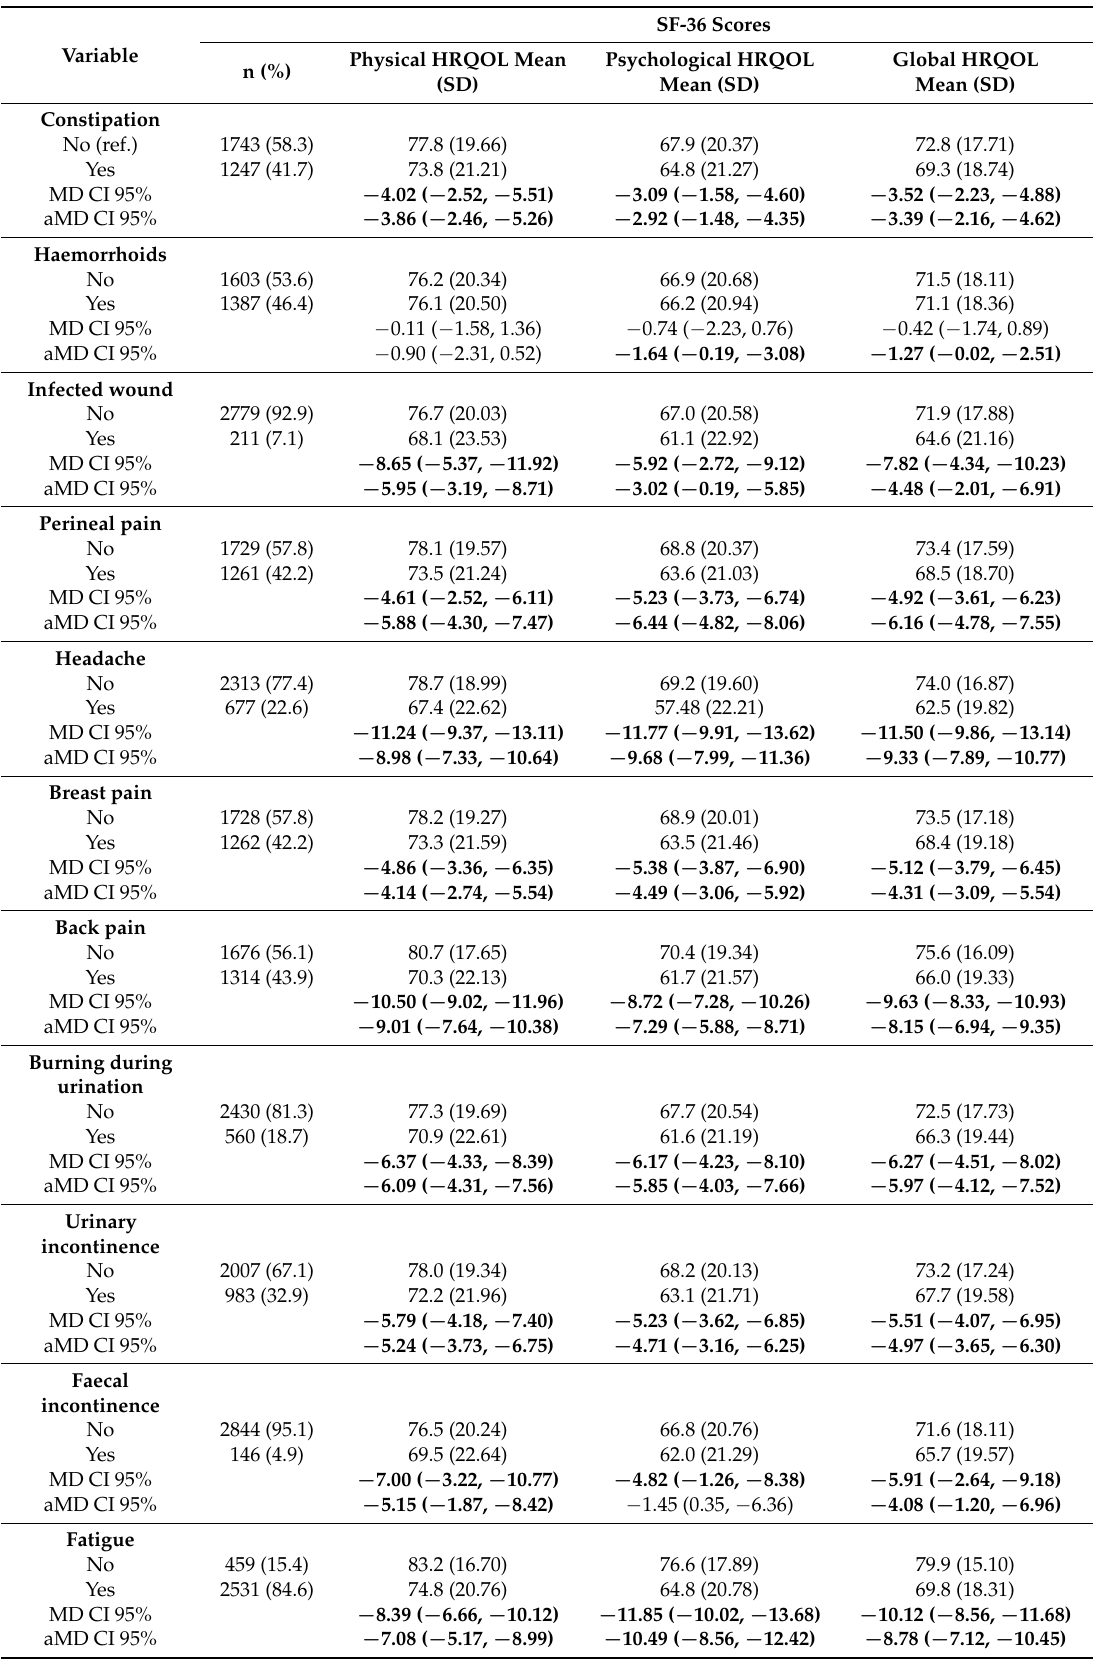
Table 2. Problems/discomfort a week after